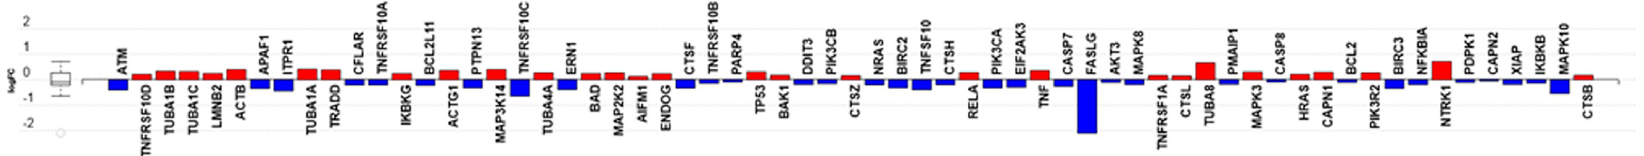
Figure 7. The focal adhesion pathway mRNA transcripts regulated in response to C16 ceramide-enriched LDL in human podocytes. Podocytes were induced with C 16 ceramide-enriched or native LDL and RNA-seq assay was performed as described in Figure 3 legend. Figure generated by iPathwayGuide (Advaita Bioinformatics) software; log FC, logarithm of fold change of gene expression. Box and whisker plot: the ends of the box are the upper and lower quartiles, box spans the interquartile range. Horizontal line inside the box denotes the median and the whiskers are the two lines outside the box extend to the highest and lowest observations.